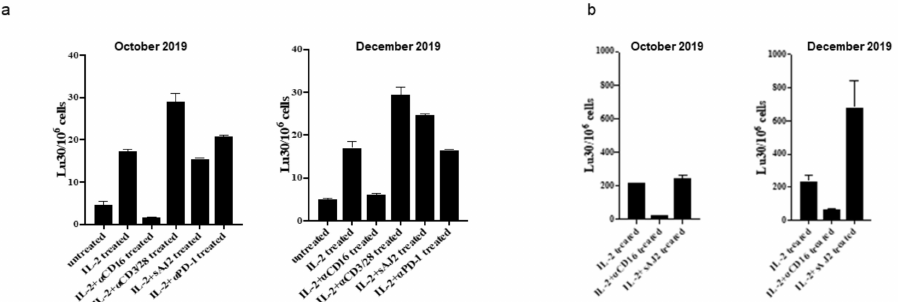
Figure 3. Cytotoxicity of NK cells improved substantially from October to December. PBMC ( a ) and NK cells sorted from PBMCs ( b ) were left untreated or treated with IL-2 (1000 U/mL), the combination of IL-2 and anti-CD16 mAb (3 µ g/mL), IL-2 and anti-CD3/28 antibody (25 mL/mL), IL-2 and sonicated probiotics (sAJ2) (bacteria: PBMC, 20:1) or anti-PD-1 antibody (10 ng/mL) for 18 h. NK cell mediated cytotoxicity using a standard 4-h chromium release assay against oral squamous cell carcinoma stem cells (OSCSCs) were performed and the lytic unit 30/106 cells were